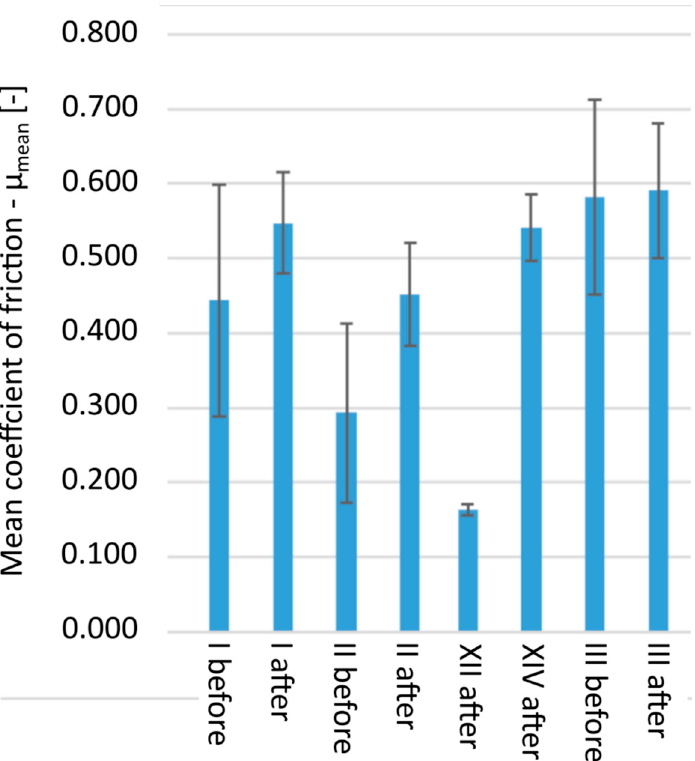
Figure 8. Changes in the stabilized coefficient of friction µ of the tested materials.